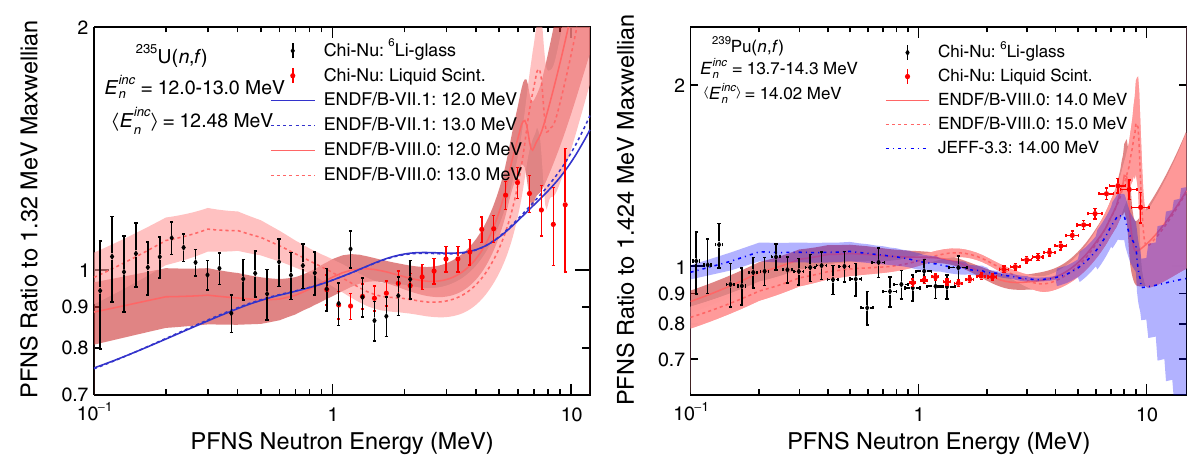
Figure 2. Second-chance fission PFNS features observed by the Chi-Nu experiment for neutron-induced fission of 235 U (left) and 239 Pu Figure 3. Third-chance fission and pre-equilibrium PFNS features observed by the Chi-Nu experiment for neutron-induced fission (right) are shown here. The experimental incident neutron-energy ranges are shown in each plot. The bands and trends correspond to of 235 U (left) and 239 Pu (right) are shown here. The bands and trends correspond to evaluations at relevant incident neutron energies evaluations at relevant incident neutron energies [12–14].